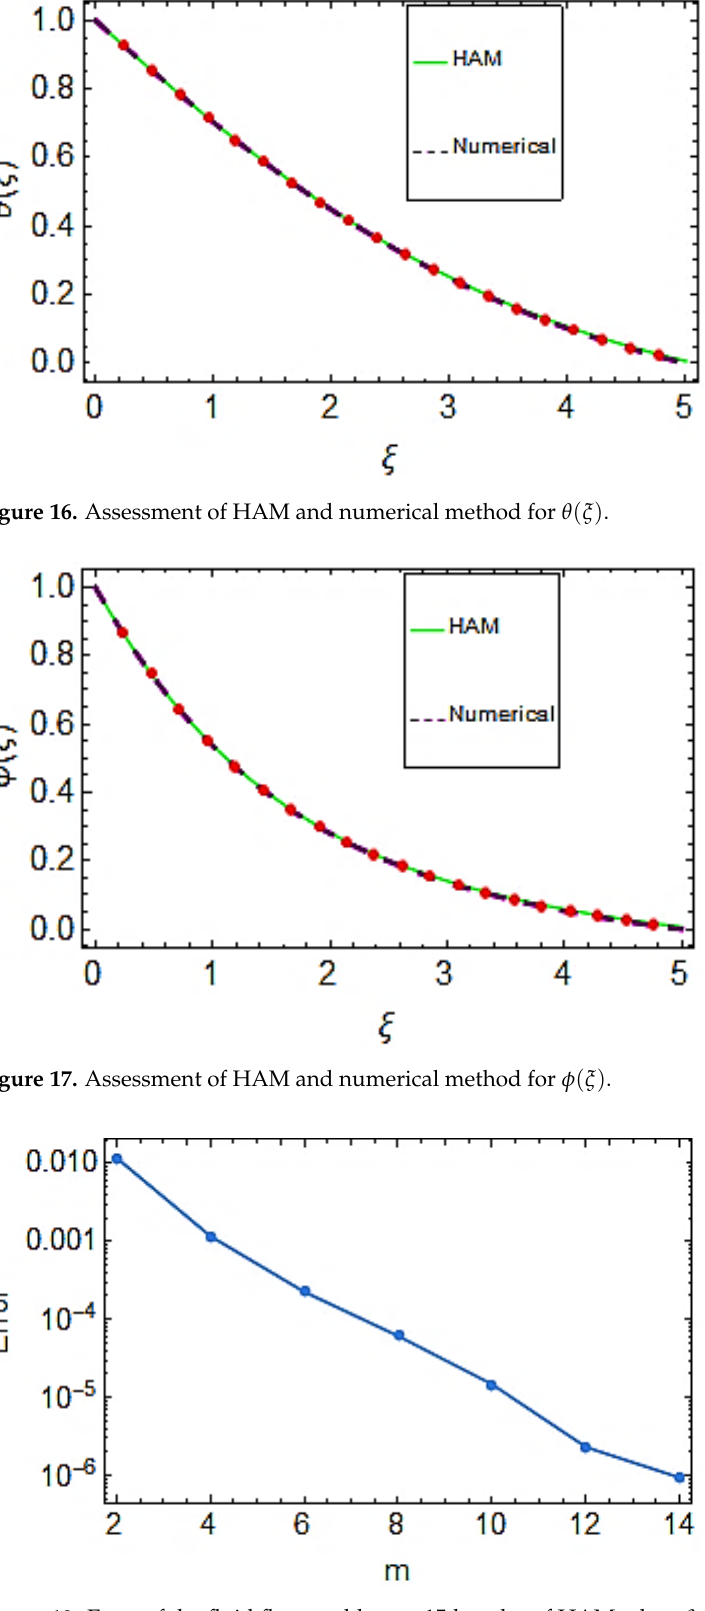
Figure 18. Error of the fluid flow problem at 15th order of HAM when β = 0.0, M = 0.2, Da = 0.5, Rd = 0.3,Pr = 1.0, Ec = 0.1, S = 0.1, Nb = 2.0, Nt = 0.5, Le = 1.0, and λ =